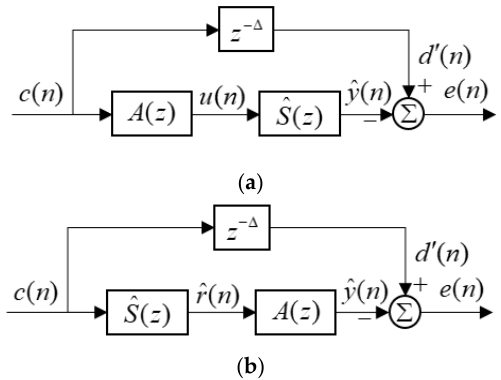
Figure 4. ( a ) Block diagram of a feedforward control for following the delayed target sound using a modelling delay. ( b ) Rearrangement of the block diagram for the design of the inverse control filter A ( z ) .